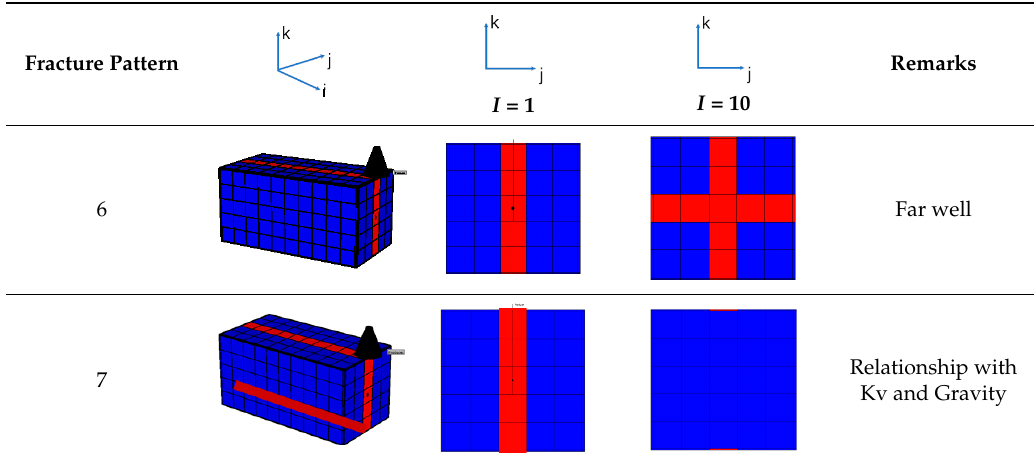
10 of 29 Table 4. Component properties and composition. Component